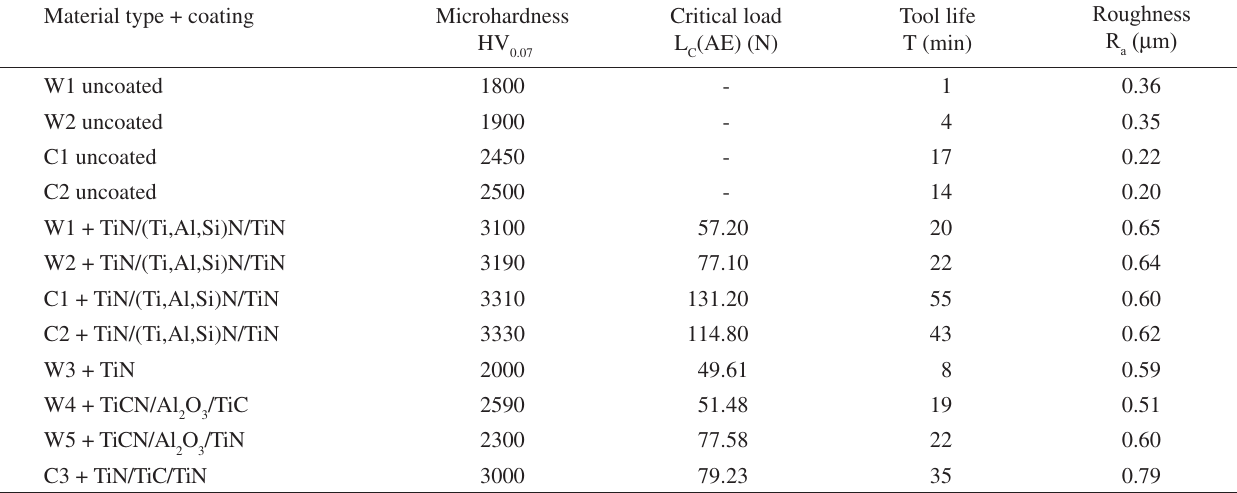
Figure 3. Fracture surface of the TiCN/AlTiCN/Al W4 type commercial cemented carbide surface. Table 2. Comparison of properties of investigated cemented carbides and cermets.